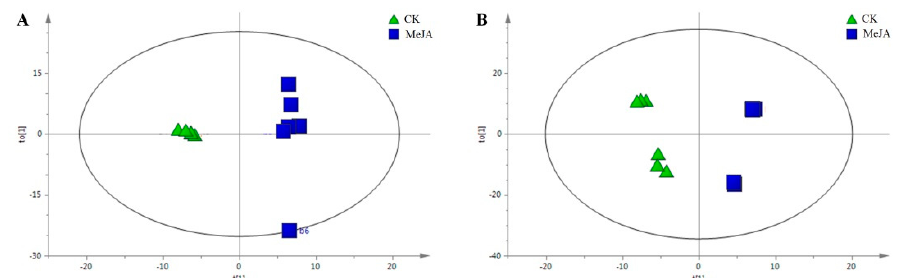
Figure 6. Orthogonal partial least square-discriminant analysis (OPLS-DA) scores scatter plot showing the complete separation of the metabolite profiles of the adventitious root grown under normal (CK) and MeJA elicitation conditions. ( A ) Methanol aqueous phase. ( B ) Chloroform phase.